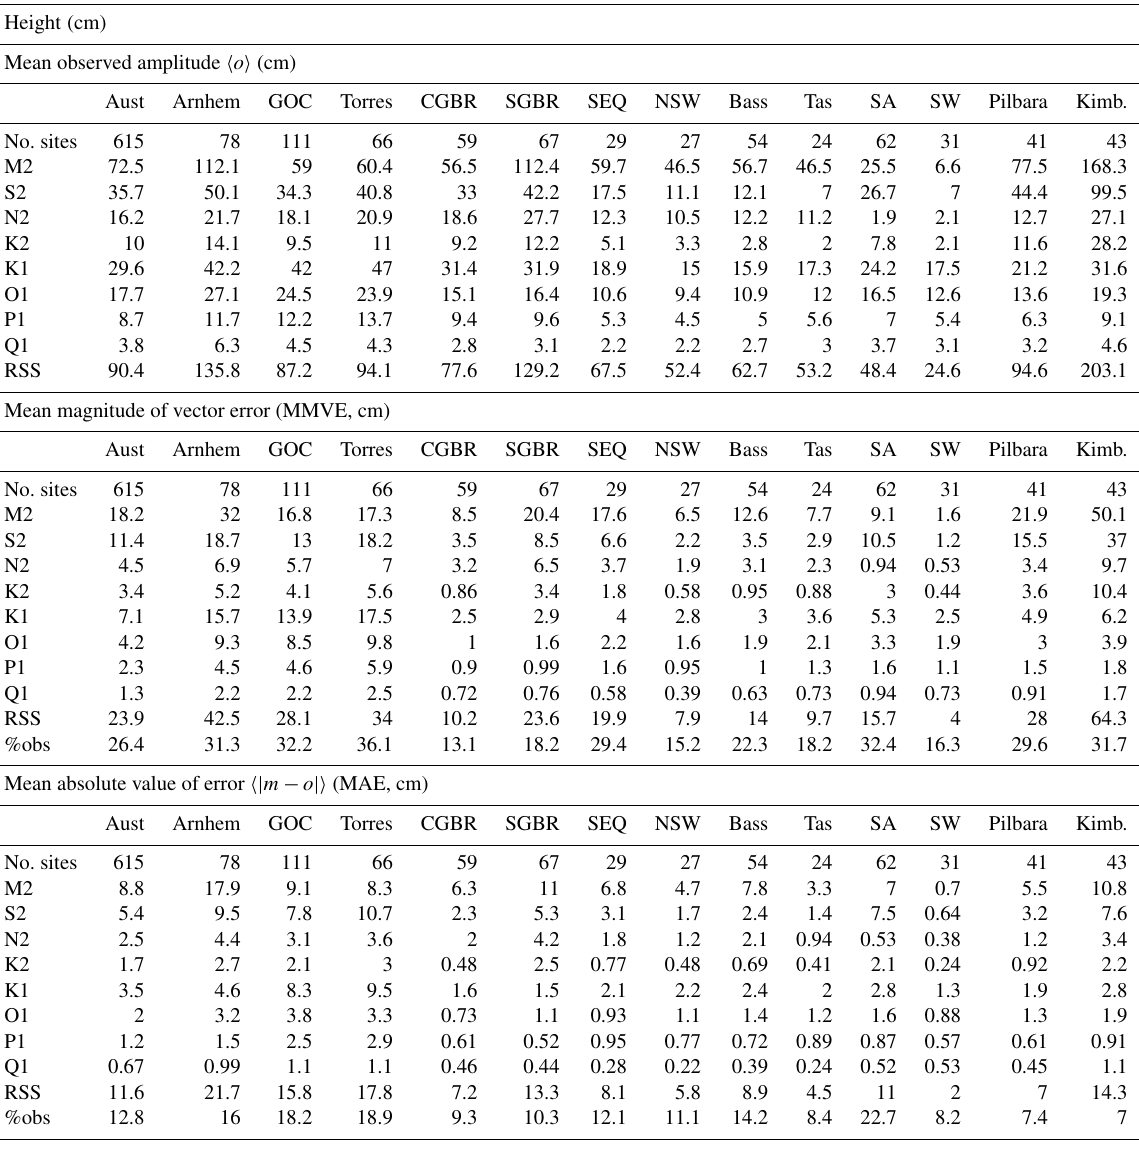
Table 2. Tidal height and phase regionally averaged statistics for eight constituents (and their root sum of squares – RSS). The %obs row expresses the RSS values in the line above as a percentage of the observed